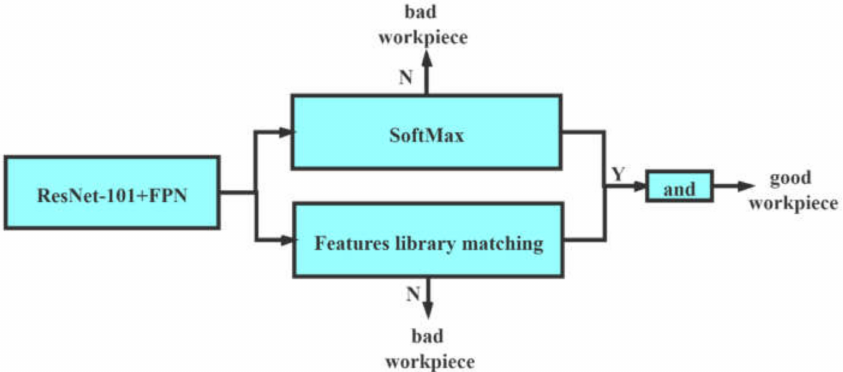
Figure 8. The double-branch discrimination